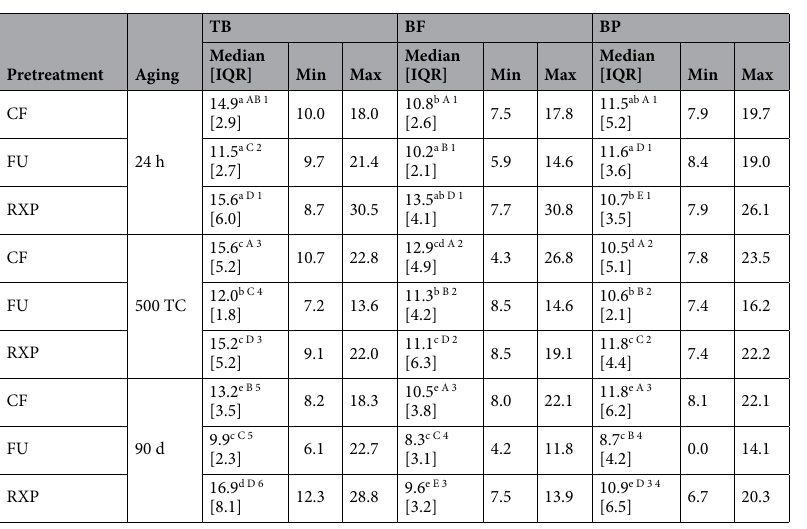
Table 2. Medians and interquartile ranges (IQR) of shear bond strengths values in MPa. Different pretreatment methods and aging regimens are represented by the rows. Different attachment materials are represented by the columns. Statistical significance of differences ( p ≤ 0.05) is indicated by superscript letters or numbers. Values that do not differ significantly share the same letter/number. In the rows different uppercase letters indicate significant differences between storage regimens and different numbers between pretreatment methods. Different lowercase letters indicate significant differences in the lines (between